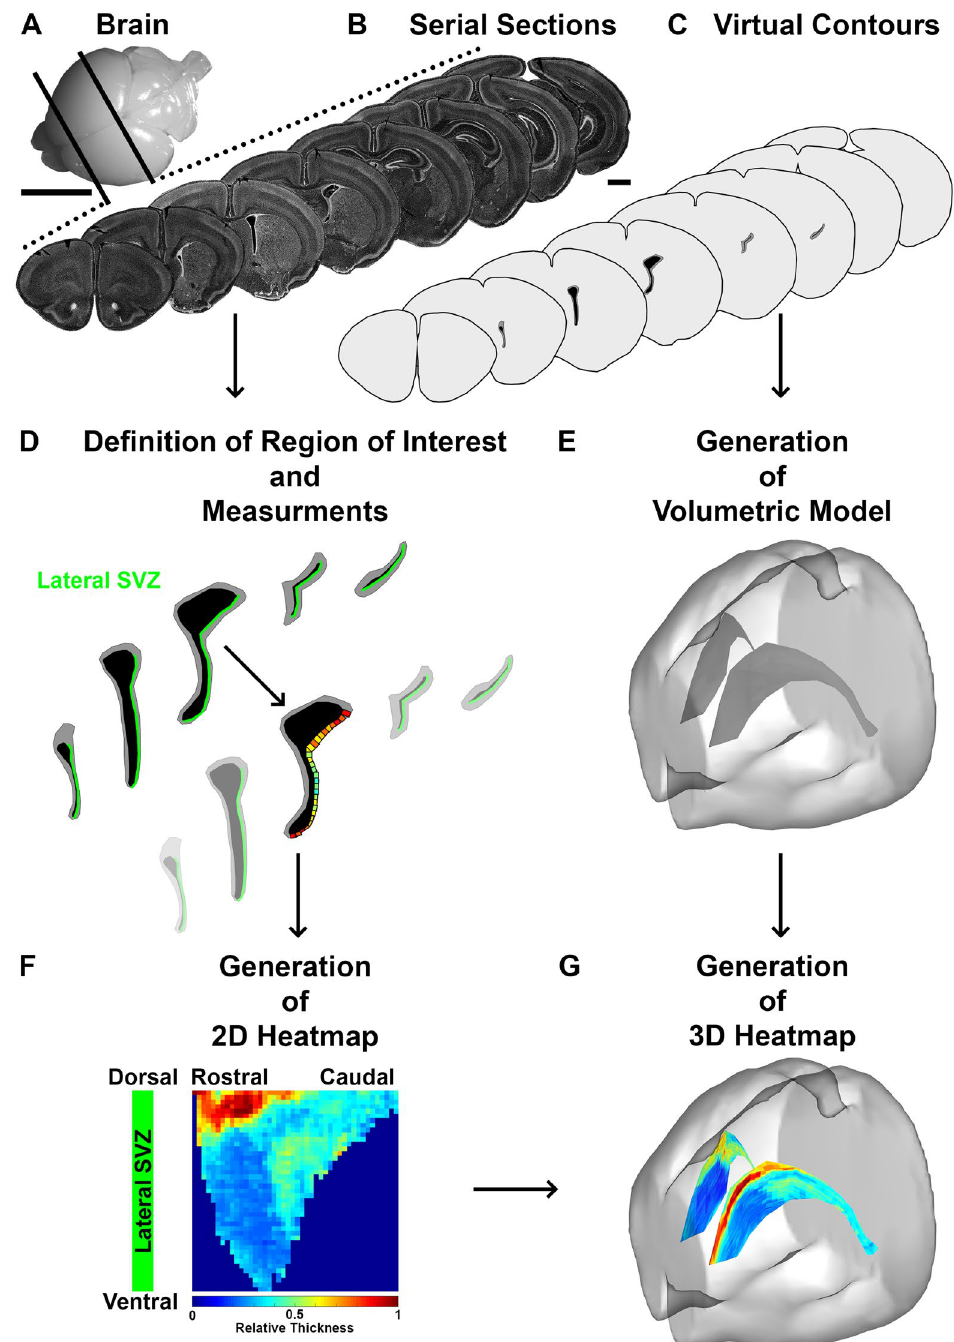
Figure 2. Schematic illustration of the full procedure for sampling and analysis of the SVZ. (A) Representative picture of a P10 mouse brain prior to cutting. (B) Representative micrographs show a subsampled series of counterstained brain sections (Dapi) covering the full rostro-caudal extent of the LV. Sections are collected/ subsampled in series according to the experimental question (here for illustration a subsampling of 1 section out of 12). (C , E) Schematic illustration of virtual contours of serial brain sections ( C ), which are used for the generation of 3D reconstructions of the brain (bright grey) and LVs (dark grey; E ). ( D ) Schematic illustration of the definition of the ROI (here lSVZ in green) and the automatic distribution of probes for OD measurements of the investigated marker. Probes width are defined by the user (in this study 50 µ m), while the height is calculated by “FlashMap”. ( F ) The software generates automatically 2D heatmaps of SVZ thickness and OD values along the rostro-caudal axis of the ROI (here lSVZ). Values (here SVZ thickness) are represented by a relative colour code (deep blue = 0 to deep red = 1 = highest value). ( G ) Heatmaps can be presented in 3D, by superimposing those onto a 3D reconstruction of the ventricular system (here complete heatmap of SVZ thickness). Scale bars: (A) = 5 mm; (B, C) = 1 mm. Abbreviations: SVZ, subventricular zone; 2D, two dimensional; 3D, three dimensional; OD, optical density; ROI, region of interest; LV, lateral